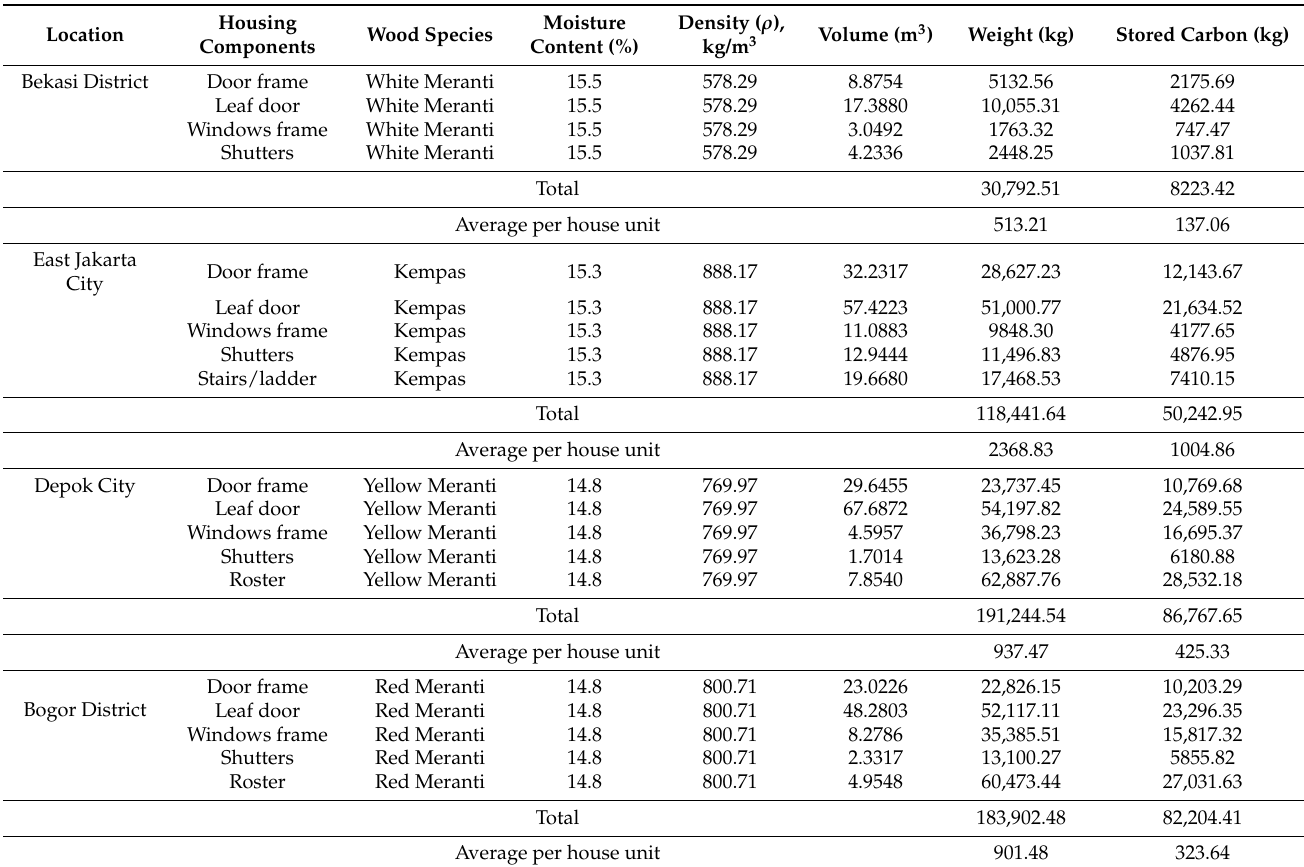
Table 6. Carbon storage of the housing based on EDX